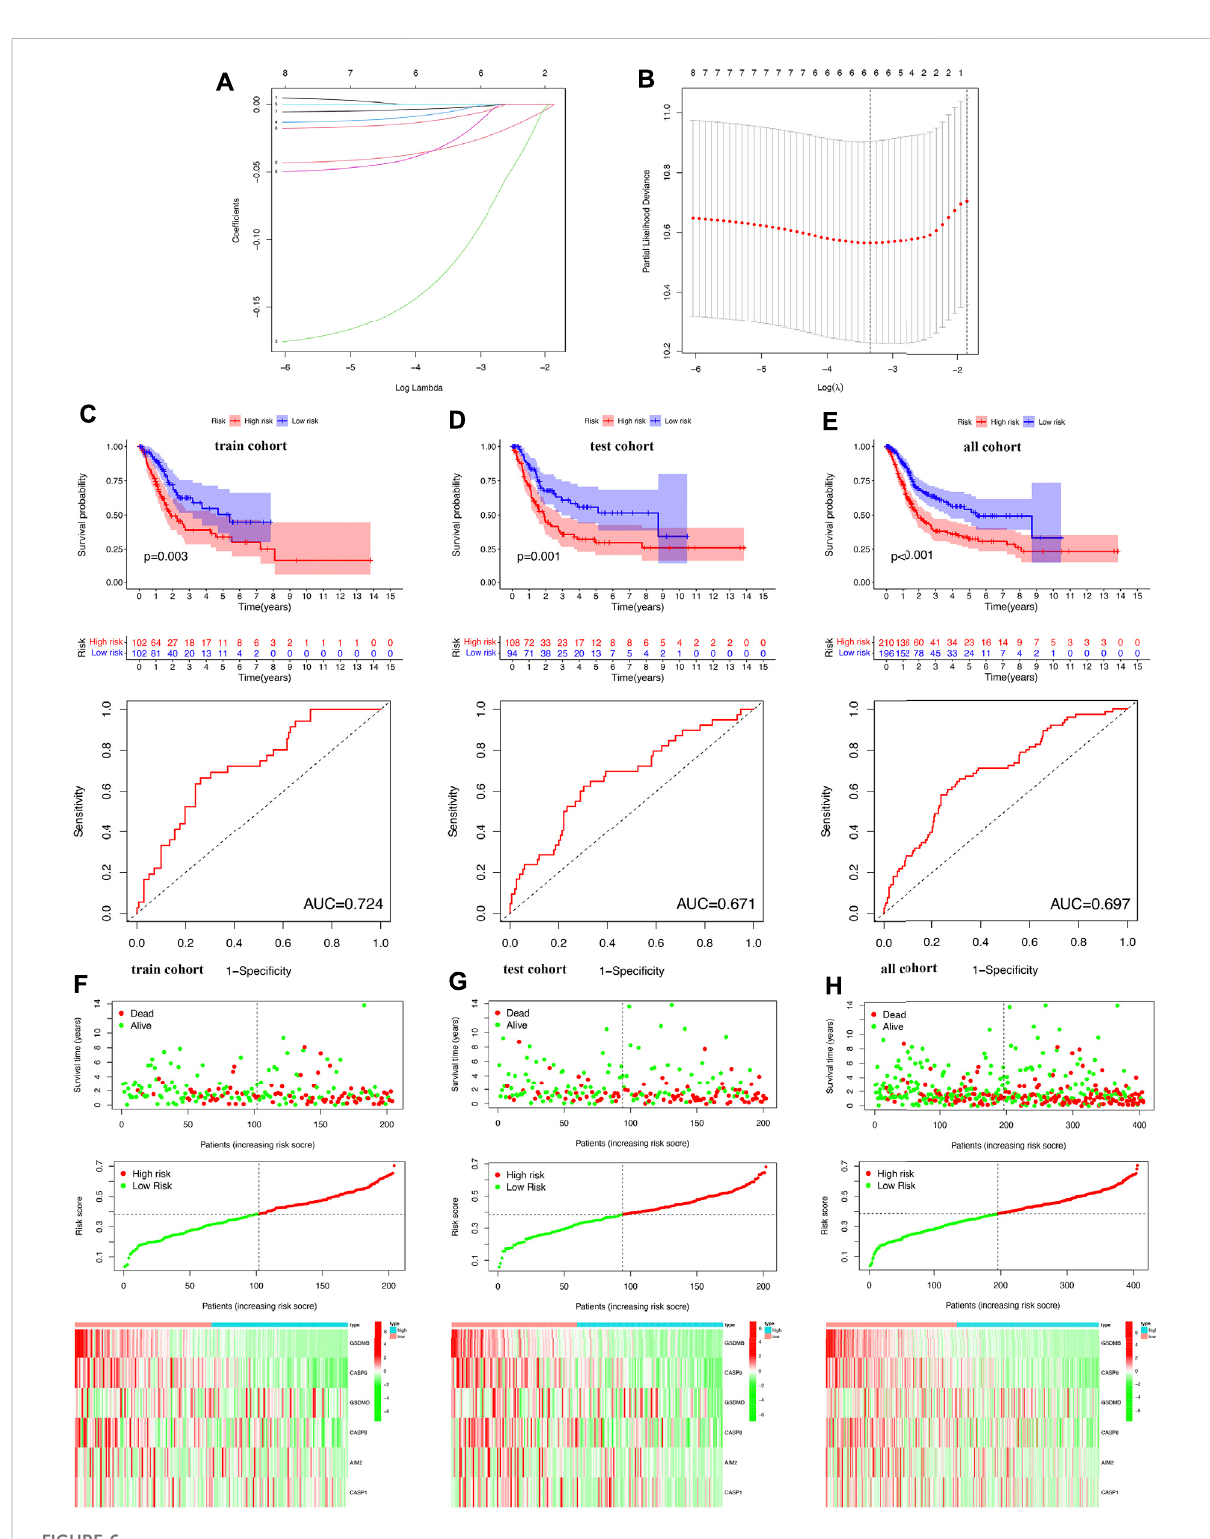
FIGURE 6 Construction of the prognostic signature in bladder cancer. (A,B) The coef fi cient and partial likelihood deviance of prognostic signature. (C – E) Overall survival curve in the high-/low-risk group and the ROC curve for prognosis predicting in the training cohort, test cohort, and bladder cancer cohort. (F – H) Riskscore distribution and survival status, the expression of prognostic PRGs in the training cohort, test cohort, and bladder cancer